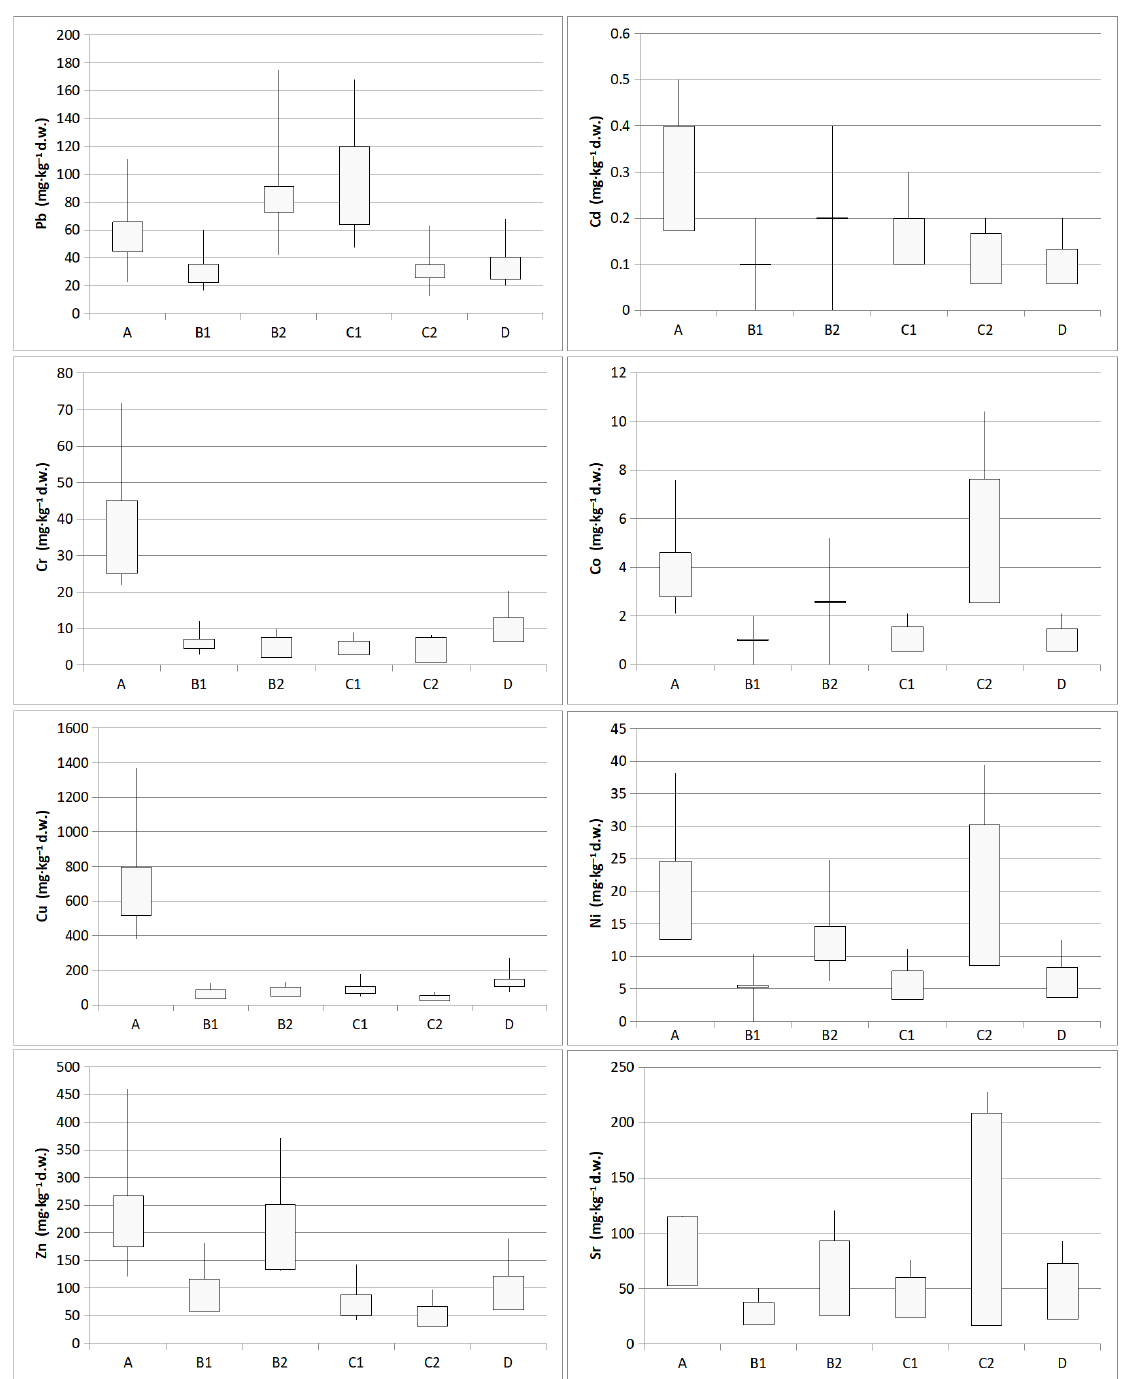
Figure 4. Potentially harmful elements (PHEs) content (mg·kg − 1 d.w.) (boxplots with min., max., mean, standard deviation) according to sampling location: A (inter-railway, depth 20 cm), B1 (5 m from the main track, depth 0–5 cm), B2 (5 m from the main track, depth 20 cm), C1 (embankment, 10 m from the main track, depth 0–5 cm), C2 (embankment, 10 m from the main track, depth 20 cm), D (side track, depth 20 cm) and fraction diameter (0.05 ≤ 0.1 mm; 0.1 ≤ 0.25 mm; 0.25 ≤ 0.5